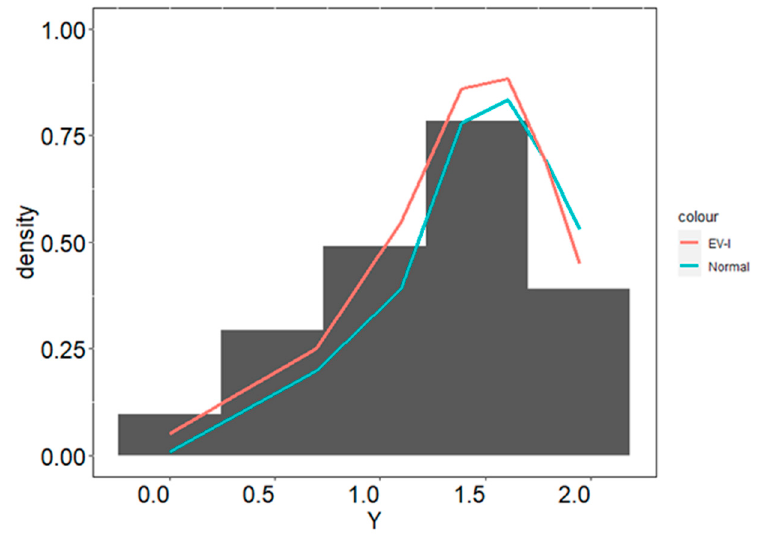
Figure 11. Comparison of predictive densities for DHF data in eastern Surabaya using the four- component EV-I mixture distribution and the four-component Gaussian mixture distribution.